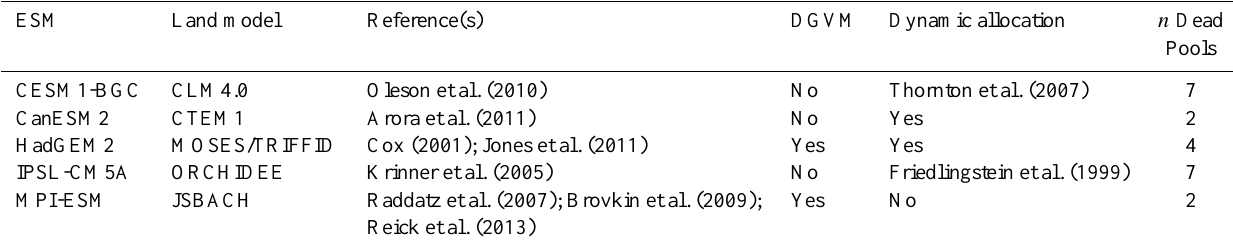
Table 1. Models used in this analysis, key references for each model, and some basic info: whether or not the models consider dynamic vegetation distributions; whether allocation of carbon to vegetation pools is dynamic or static; and the number of litter, coarse woody debris (CWD) and soil organic matter (SOM) pools that constitute the dead carbon